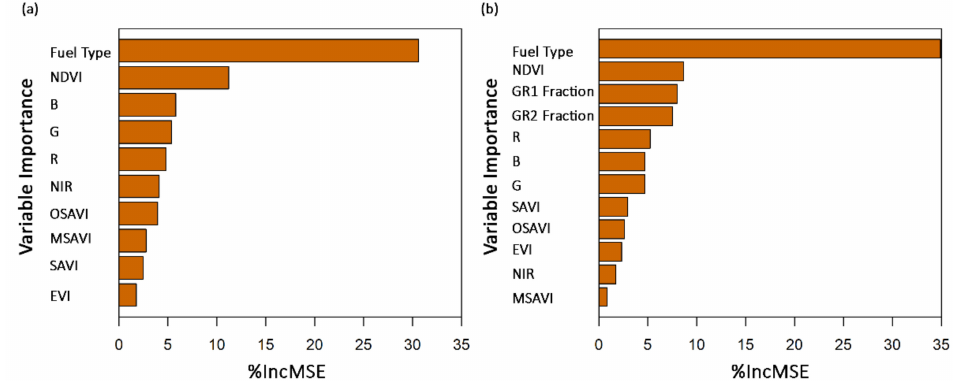
Figure 6. The variable importance for biomass models, based on medium spatial resolution images, ( a ) without and ( b ) with fractional cover as explanatory variables. The X -axis is the percent increase in Mean Square Error (%IncMSE). BGfraction and GRfraction are the fractional cover of GR1 and GR2, respectively.